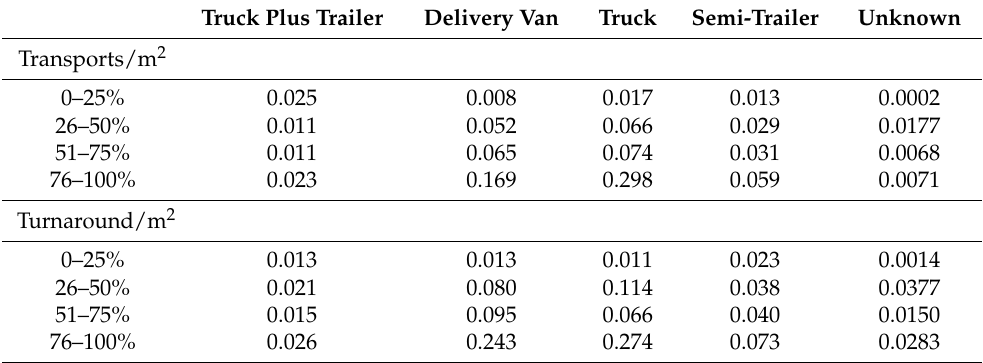
Table 7. Transports and turnaround per m 2 for different vehicles during different completion